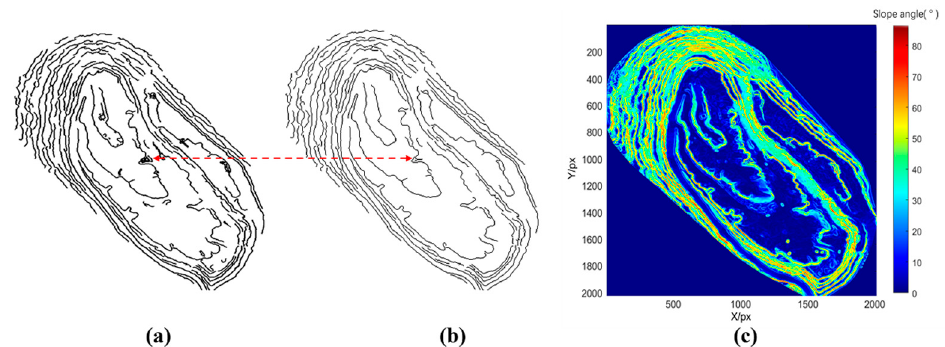
Figure 14. ( a ) Detection results without slope-threshold optimization; ( b ) detection results of step- feature points with slope-threshold optimization; ( c ) slope distribution of the open-pit mine.